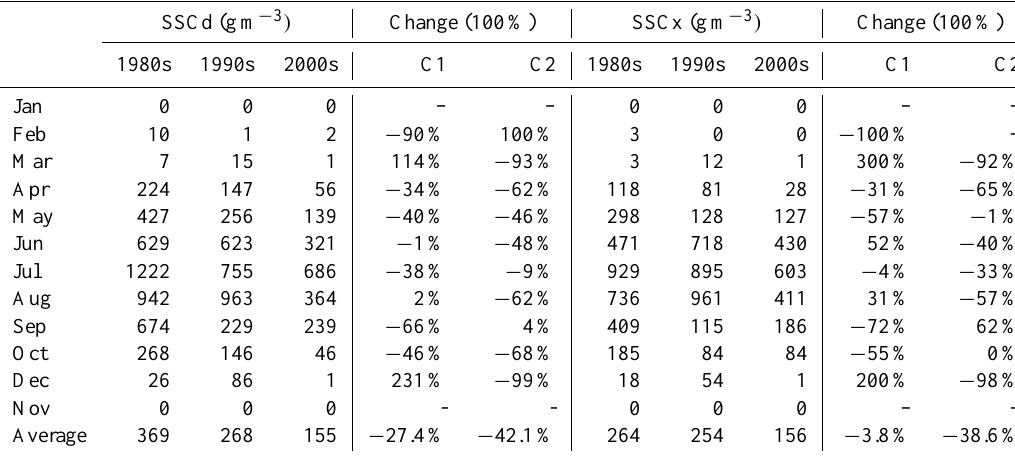
Table 5. Monthly mean suspended sediment concentration from the Xinzhou and Zhushan gauges.